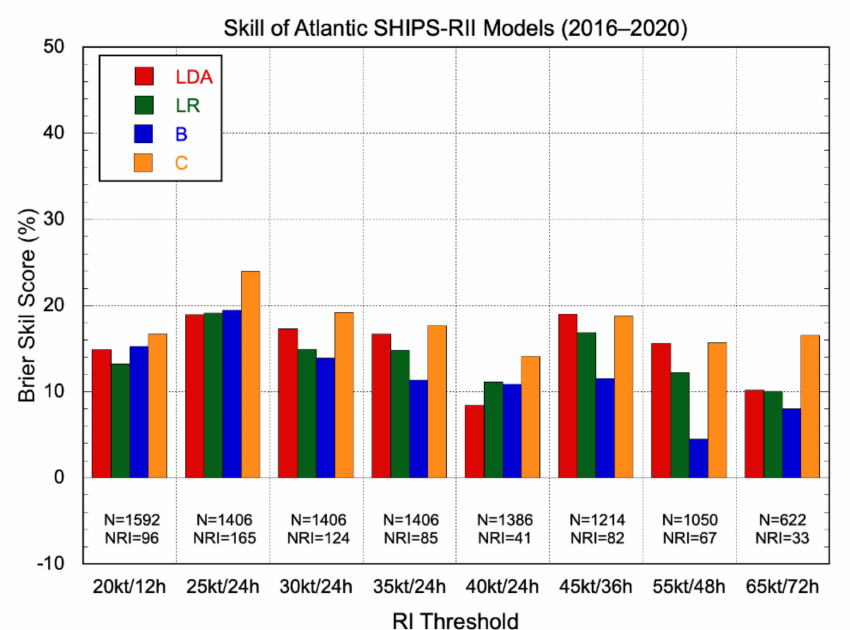
Figure 5. Brier skill scores for 2016–2020 Atlantic basin real-time SHIPS-RII-LDA (red), SHIPS-RII-LR (green), SHIPS-RII-B (blue), and SHIPS-RII-C (orange) model forecasts relative to climatology. The different RI thresholds are listed below each bar grouping, along with the total number of cases and the number of those cases for which RI occurred. Negative scores depict thresholds for which the model had less skill than